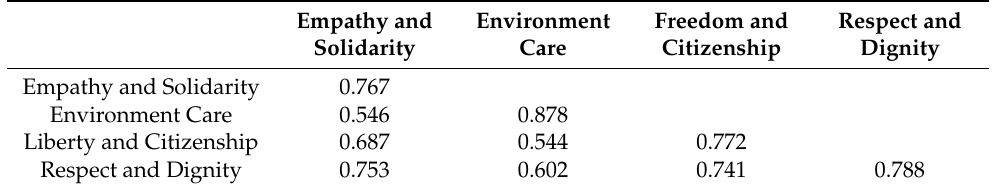
Table 5. Discriminant validity.